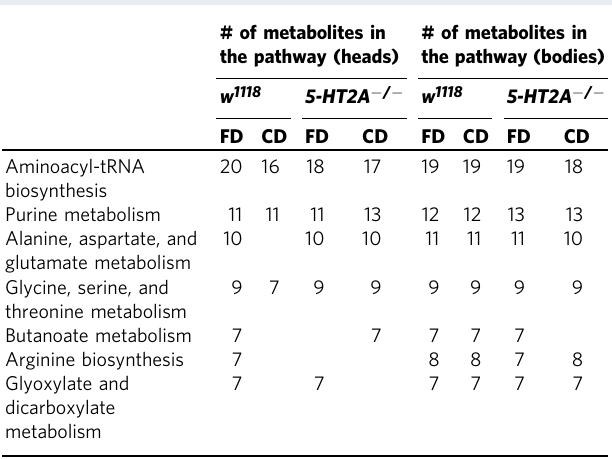
Table 1 Pathway analysis on the metabolites from each core